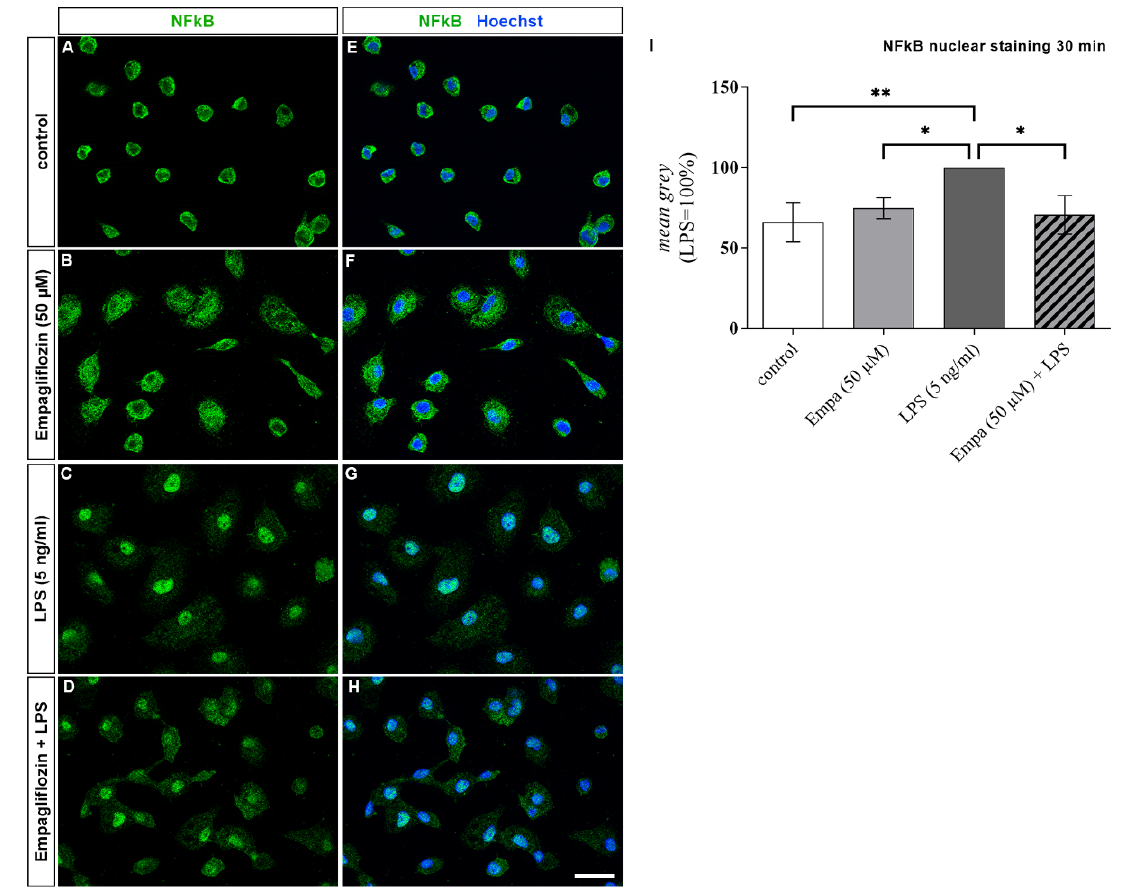
Figure 7. Representative images of immunofluorescence staining showing the distribution pattern of NFkB (green) in rat primary microglia after 30 min of stimulation. Nuclei were counterstained with Hoechst (blue). Nuclear NFkB signal intensity was quantified using ImageJ ( I ). Unstimulated control cells showed predominately cytoplasmatic NFkB staining ( A , E ), whereas LPS (5 ng/mL) stimulation resulted in a significant NFkB translocation into the nuclei ( C , G , I ). Co-treatment with LPS and empagliflozin (50 µM) significantly reduced NFkB translocation ( D , H , I ). Distribution pattern of microglia stimulated with empagliflozin alone ( B , F , I ) was similar to control cells (scale bar = 20 µM; asterisks indicate all significant differences; * p ≤ 0.05, ** p ≤ 0.01; one-way ANOVA, followed by Tukey test; F-value = 8.266; n = 3).